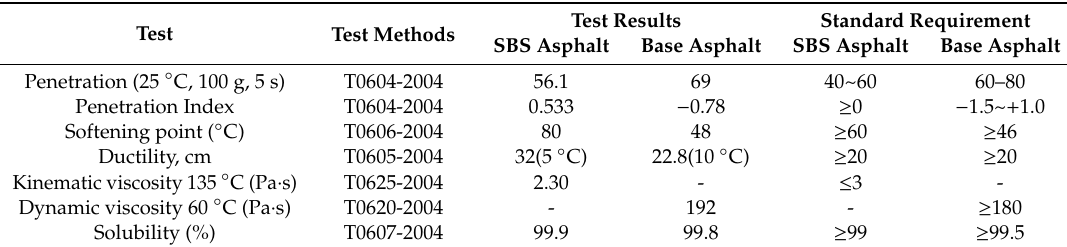
Table 2. The key index of two type of asphalt.